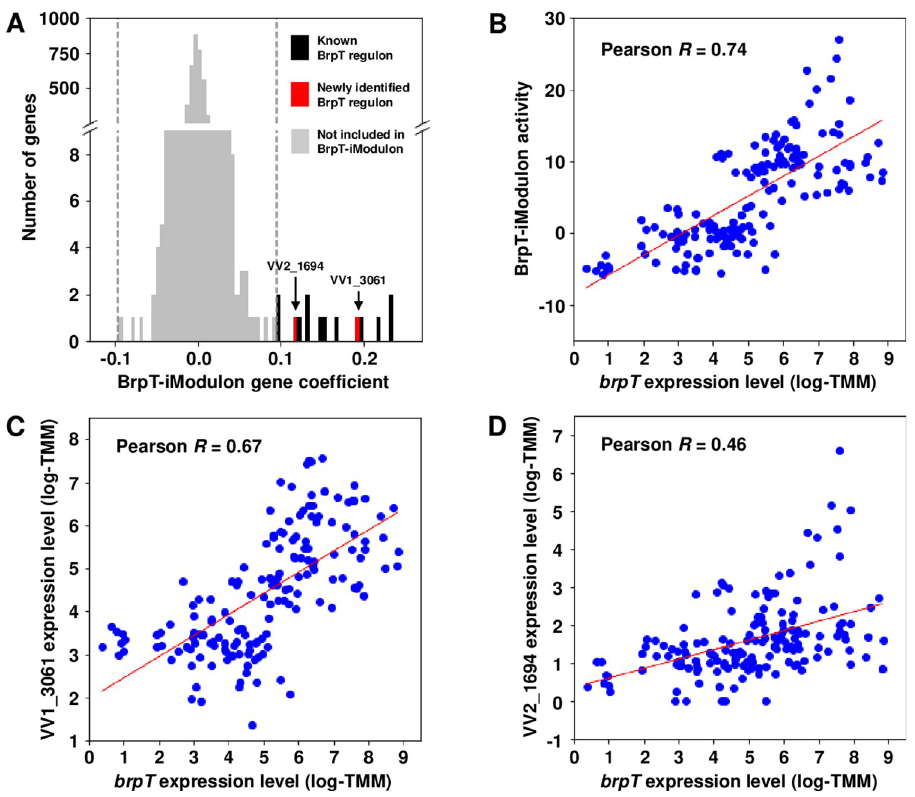
Fig 3. Validation of the BrpT-iModulon. (A) A histogram of the gene coefficients in the BrpT-iModulon. The gray dashed lines show the cutoff values of the gene coefficients. Newly identified members of the BrpT regulon, VV1_3061 and VV2_1694, are presented with red bars. (B to D) Scatter plots of the expression levels of brpT and the activities of the BrpT-iModulon (B), the expression levels of VV1_3061 (C) and VV2_1694 (D). The expression levels are represented as log-TMM, log-transformed read counts after normalization using the trimmed mean of M-values (TMM) method. The Pearson R values between the two variables are denoted in the boxes. Each dot of the plots represents a single biological replicate. The red lines represent each regression line of the